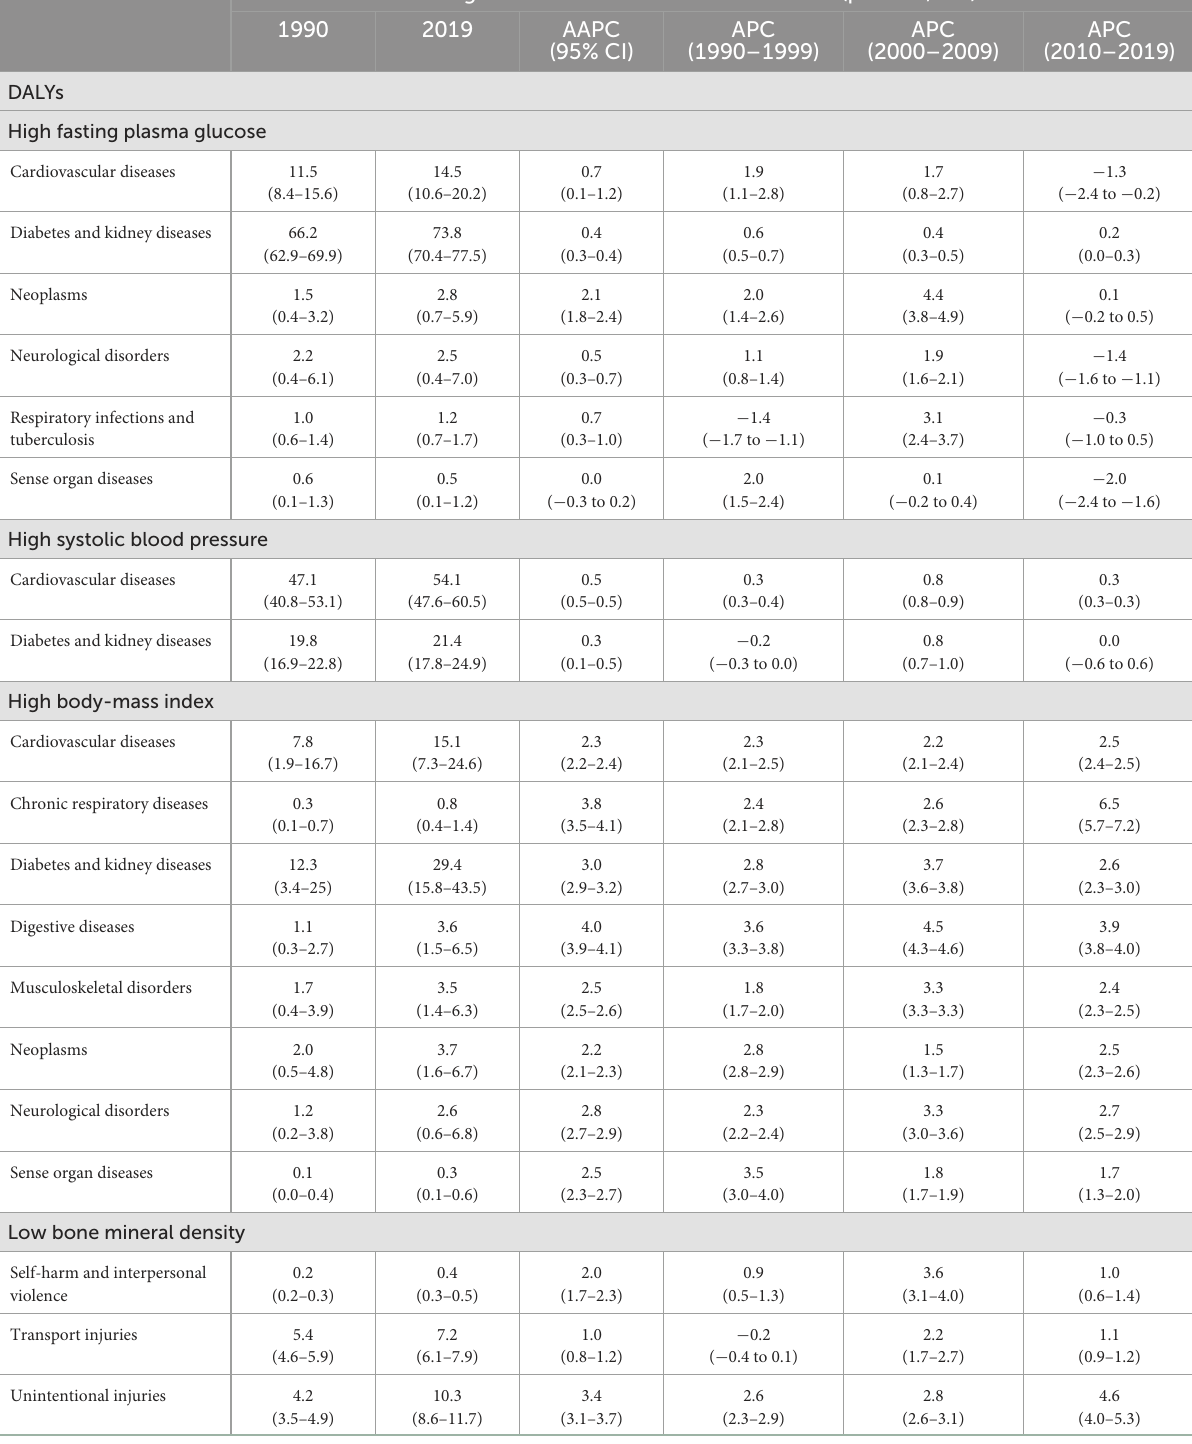
TABLE 3 Trends in the population attributable fraction on the age-standardized rate of DALYs and death of level 2 causes attributable to six metabolic risk factors,